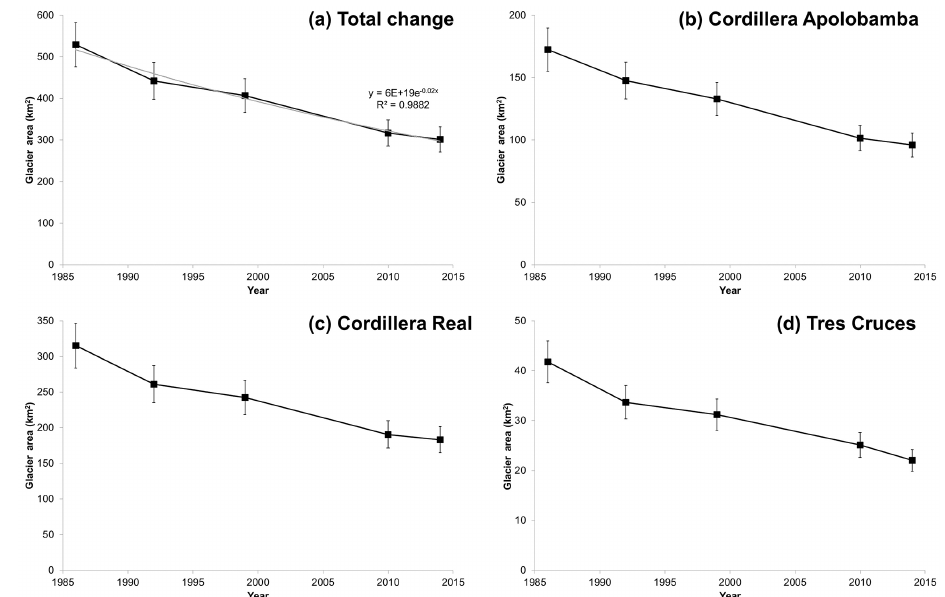
Figure 3. Glacier areal change across the Bolivian Cordillera Oriental. (a) Total glacier area change (grey line is exponential best-fit relation- ship with associated equation and r 2 value); (b) Cordillera Apolobamba (excluding glaciers on the Peruvian side of the border); (c) Cordillera Real; (d) Tres Cruces region. Error bars are determined using Eq. (1) and represent an uncertainty of ± 10%.